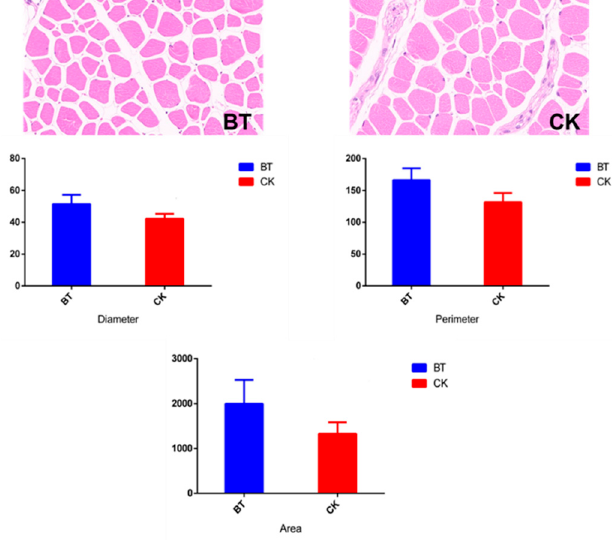
Figure 1. The muscle fiber characteristics in longissimus dorsi muscles. BT, Black Tibetan sheep group; CK, Chaka sheep group. Table 1. The muscle fiber characteristics of Black Tibetan and Chaka sheep. BT 1 CK 2 SEM 3 p -Value Diameter, μ m